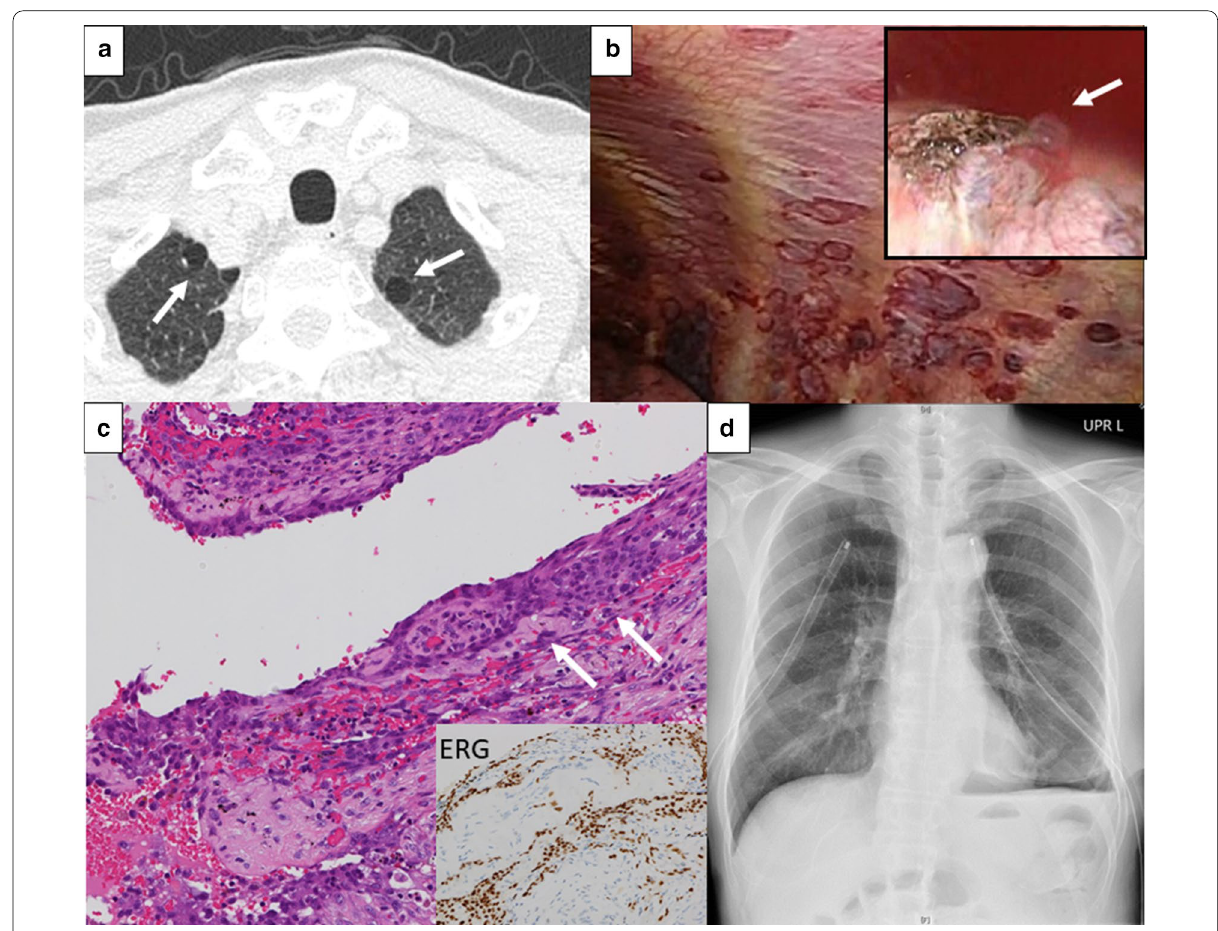
Fig. 2 a CT, performed 1 week before diagnosed with pneumothorax, showed bullae lesions in the apex (arrows). b Intraoperative findings demonstrated bulla in the left apex (arrow) and numerous dark-red spots in the parietal pleura. c Pathological findings showed atypical spindle-like cells positive for ERG infiltrating the visceral pleura (arrows). d Chest X-ray showed expansion of the bilateral lung; however, pleurodesis was